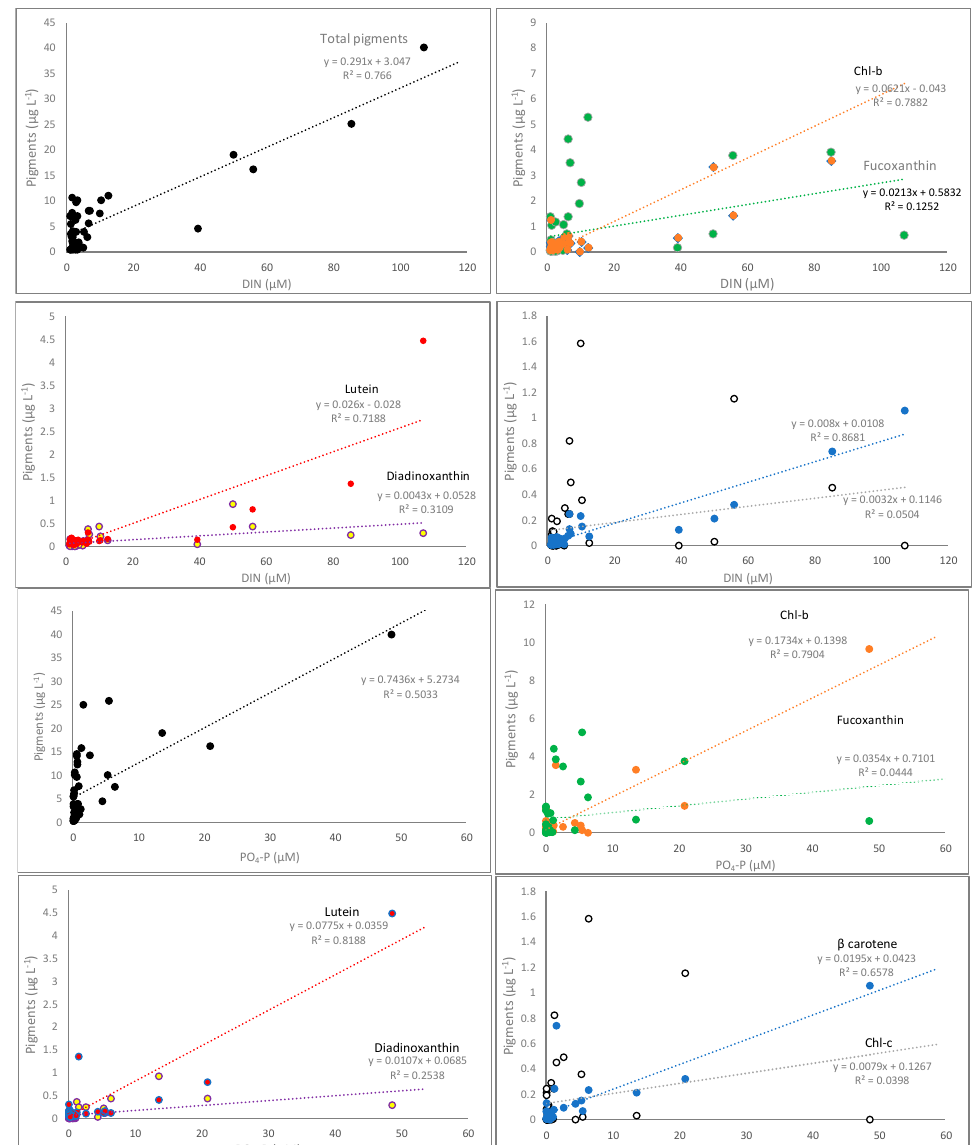
Figure 4. Linear regression analysis between nutrients and algae pigments: between dissolved inorganic nitrogen (DIN) and pigments (four upper graphs) and phosphorus (PO 4 -P) and pigments (four lower graphs) at all bays studied.